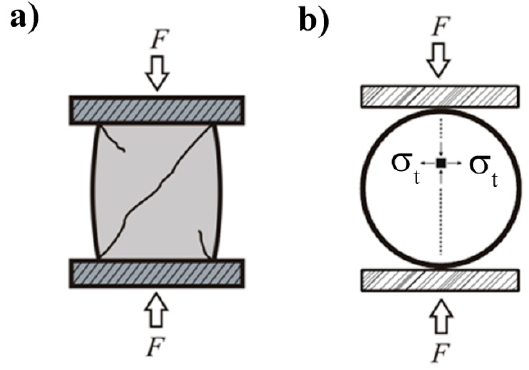
Figure 1. Test schemes for cylindrical specimens: ( a ) compression; ( b ) splitting ( σ t is the tensile stress).